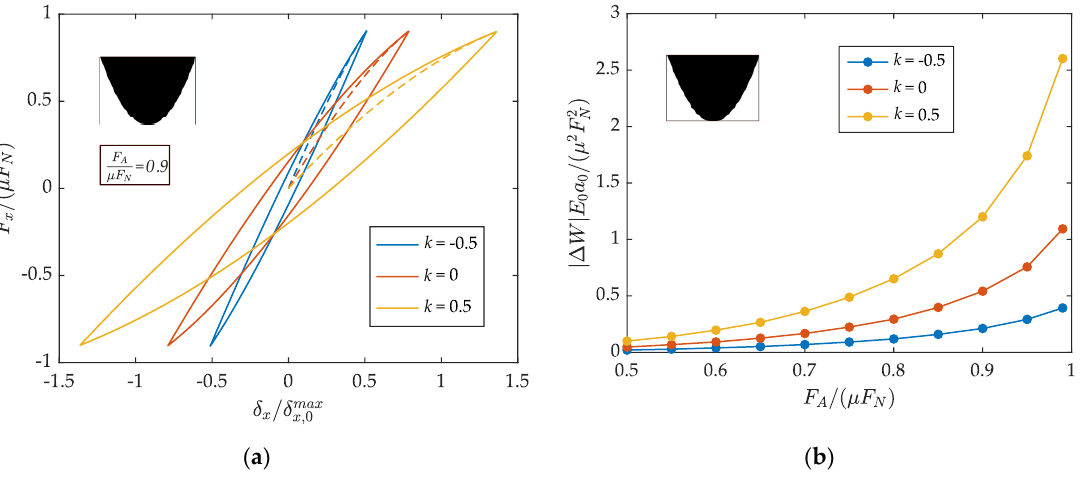
Figure 9. Hysteresis curve and energy dissipation of a parabolic indenter for various elastic inho- mogeneities 𝑘 : ( a )Tangential force over the tangential displacement; ( b ) Energy dissipation over the traction ratio 𝐹 𝐴 . 𝜇𝐹 𝑁 ratio F A . µ F N